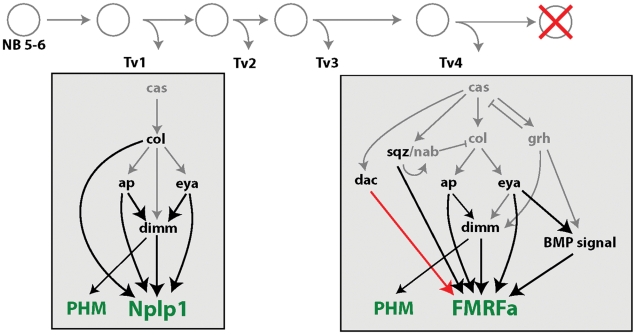
Summary of changes in subtype transcription network configuration between initiation and maintenance of subtype identity.Following terminal differentiation, Tv1 and Tv4 maintain expression of terminal differentiation genes (green text). Tv1 (PHM and Nplp1). Tv4 (PHM and FMRFa). The expression of transcription factors in grey text is lost by larval stages, all transcription factors in black text are retained in adult Tv1/4 neurons. Notably, all black transcription factors have been implicated in differentiation of subtype-specific neuropeptide expression in postmitotic Tv1/4 neurons. In contrast, all grey transcription factors have been implicated in the specification of Tv neuron subtype fates, and not in direct differentiation of subtype neuropeptide gene expression. All remaining transcription factors are required for maintained Nplp1 and FMRFa expression (black arrows), but their cross-regulatory relationships are mostly lost in adults (grey arrows). The only transcription factors that maintain their embryonic configuration are ap and eya's requirement for dimm in Tv1, and eya's continued regulation of active BMP signaling in Tv4. Dac plays an enhanced role in FMRFa expression in adult Tv4 neurons (red arrow).